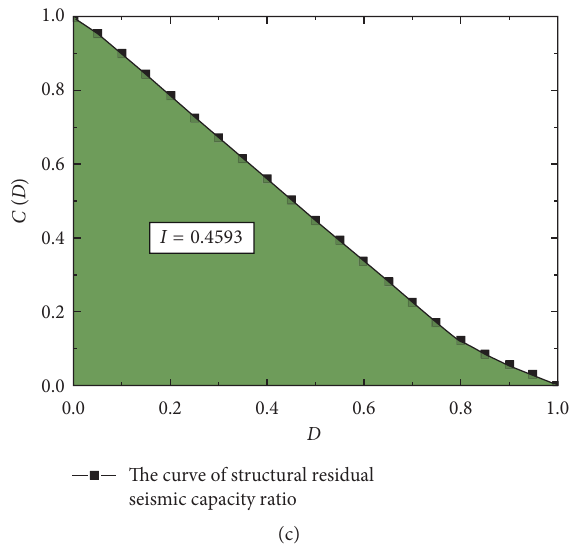
Figure 7: Residual ratio curve of the overall seismic capacity. (a) Section R-A. (b) Section R-C. (c) Section R-F.